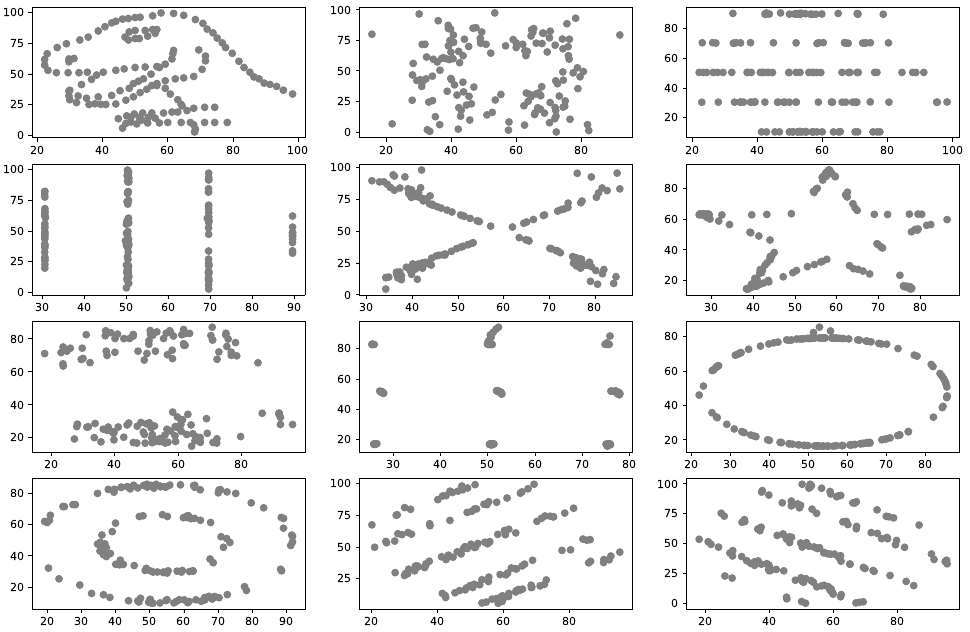
Figure 1. Same Mean, Standard Deviation and Pearson’s Correlation Coefficient but Different Dependency Structure, adapted from